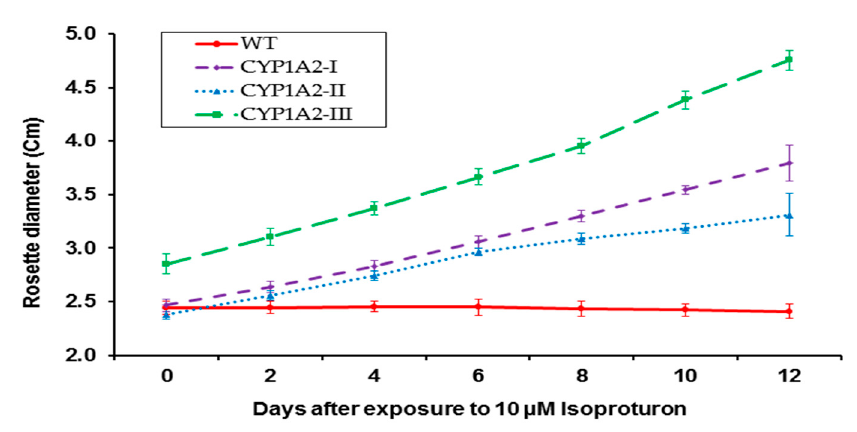
Figure 3. The effects of isoproturon applied by foliar spray on rosettes. WT: wild; CYP1A2 -I, CYP1A2 -II, and CYP1A2 -III: transgenic A. thaliana plants CYP1A2 . ( p < 0.05).